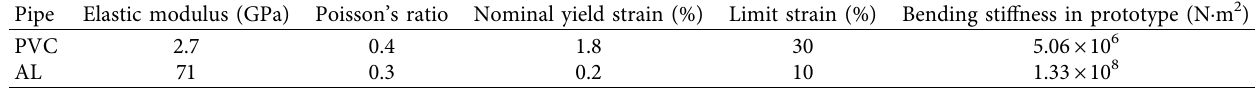
Table 4: Pipe parameters in model.